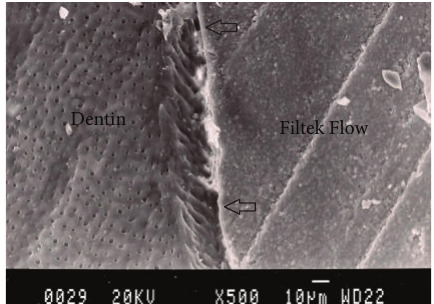
Figure 2: Representative SEM photomicrograph of a Group 2 spec- imen (Filtek Flow, in bulk). The arrows indicate large microgap formation between Filtek Flow and dentin.